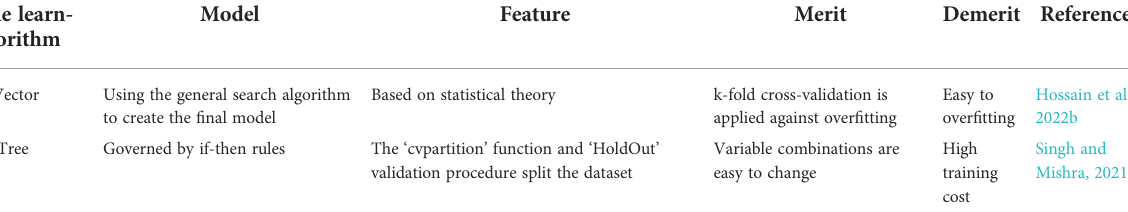
TABLE 3 Machine learning algorithms and models used in environmental protection. Machine learn- ing